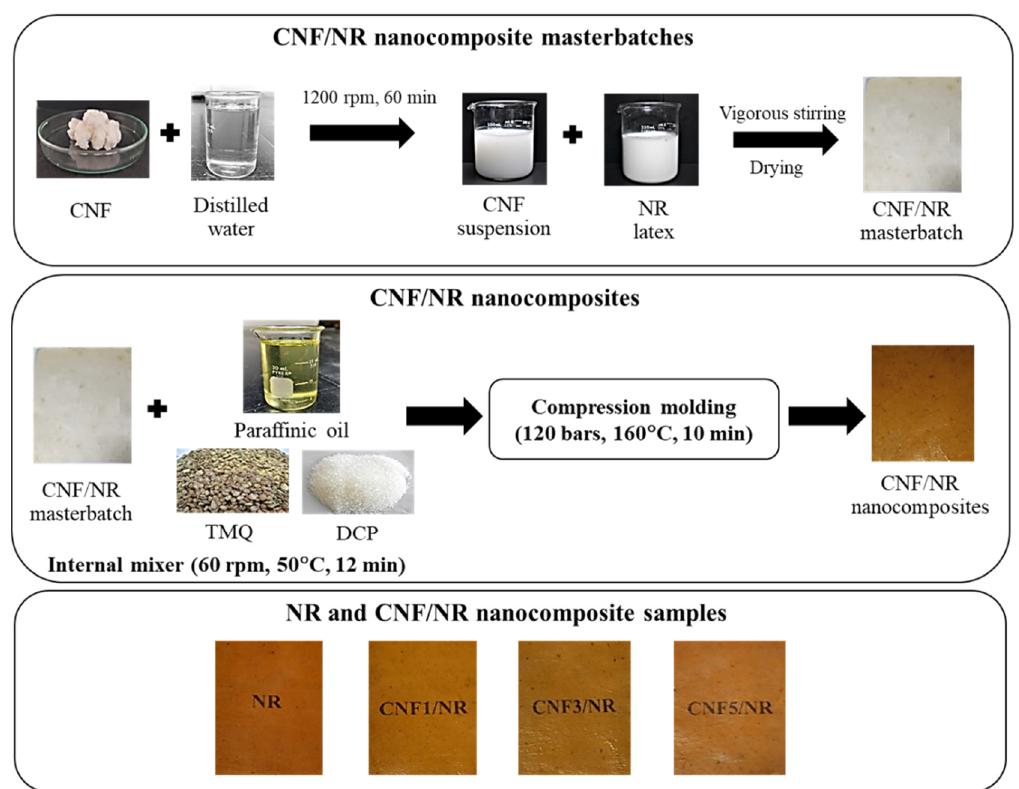
Figure 1. Schematic diagram of the preparation of the NR and the CNF/NR nanocomposites.